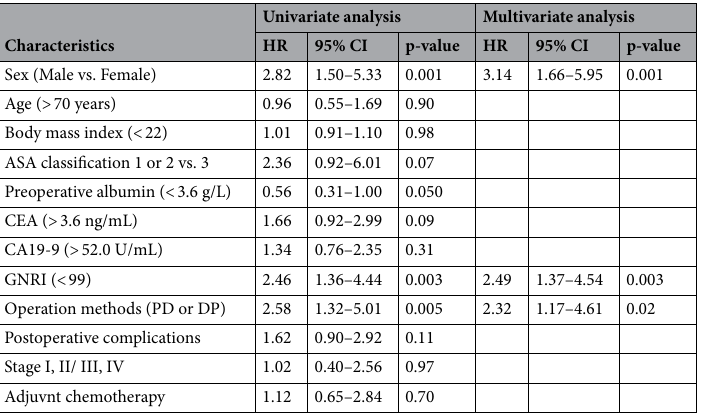
Table 4. Prognostic factors for the overall survival in patients with pancreatic cancer. ASA, American Society of Anesthesiologists; GNRI, geriatric nutritional risk index; PD, pancreatoduodenectomy; DP, distal